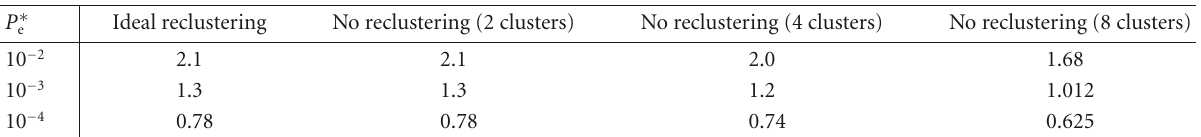
Table 1: Sensor network lifetime corresponding to an outage probability equal to 90% for the scenarios considered in Figure 6. The lifetime of each sensor has an exponential distribution with μ = 1 aU. All time values in the table entries are expressed in aU.